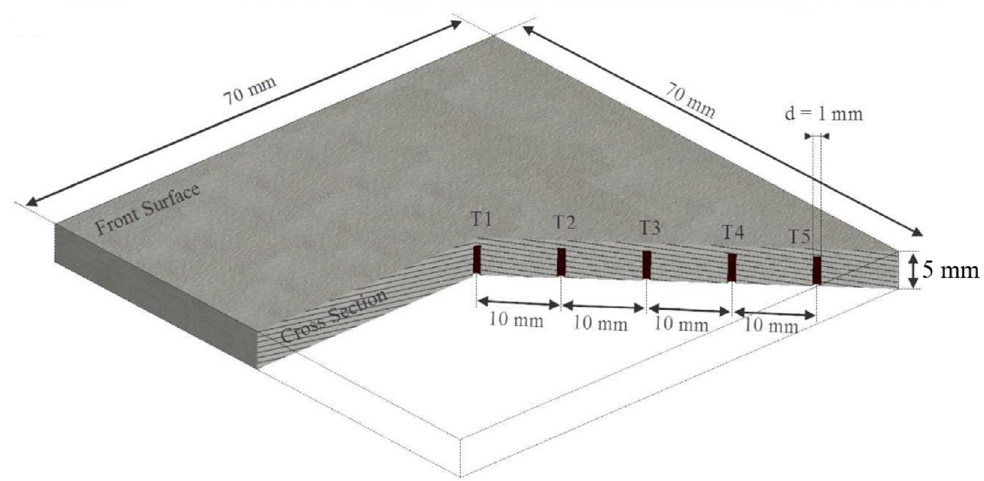
Figure 4. Cross section of titanium substrate showing exact placement of diagonally oriented five K-type thermocouples from rear side